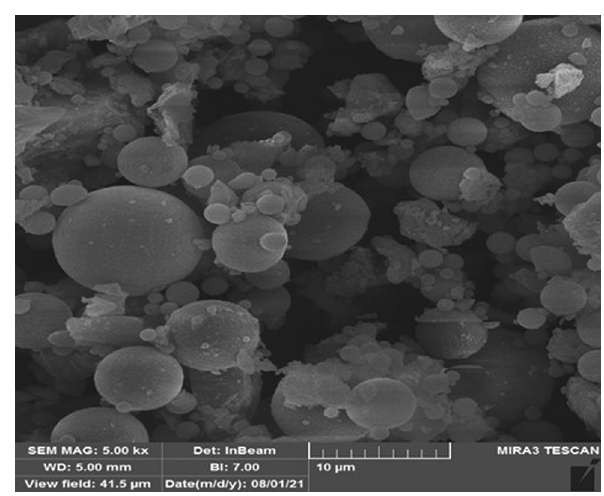
Figure 2: SEM image of FA.